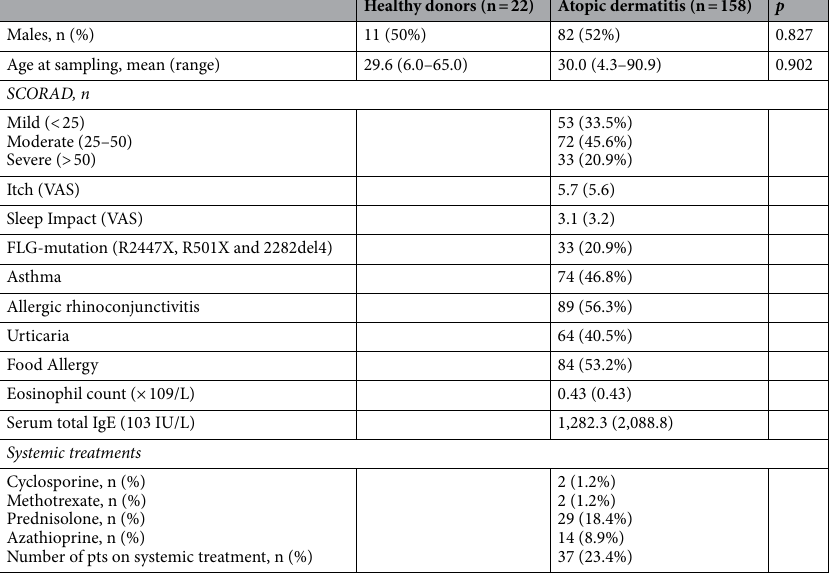
Table 4. Patient Demographics for Cohort 2. Categorical variables are written as number (percentage), while continuous variables are mean (standard deviation). SCORAD, SCORing Atopic Dermatitis; FLG, Filaggrin gene; VAS, visual analogue scale; pts, Patients.